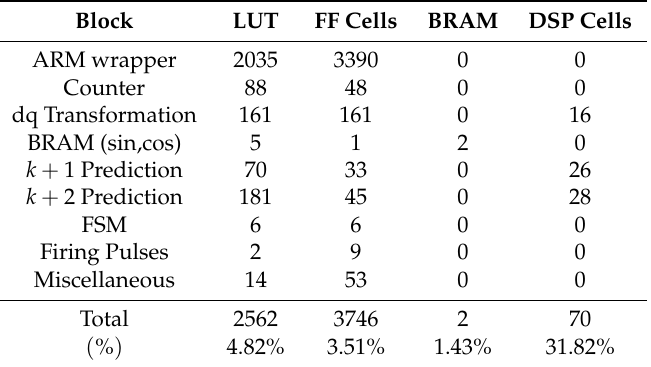
Table 4. Hierarchical utilization for sequential